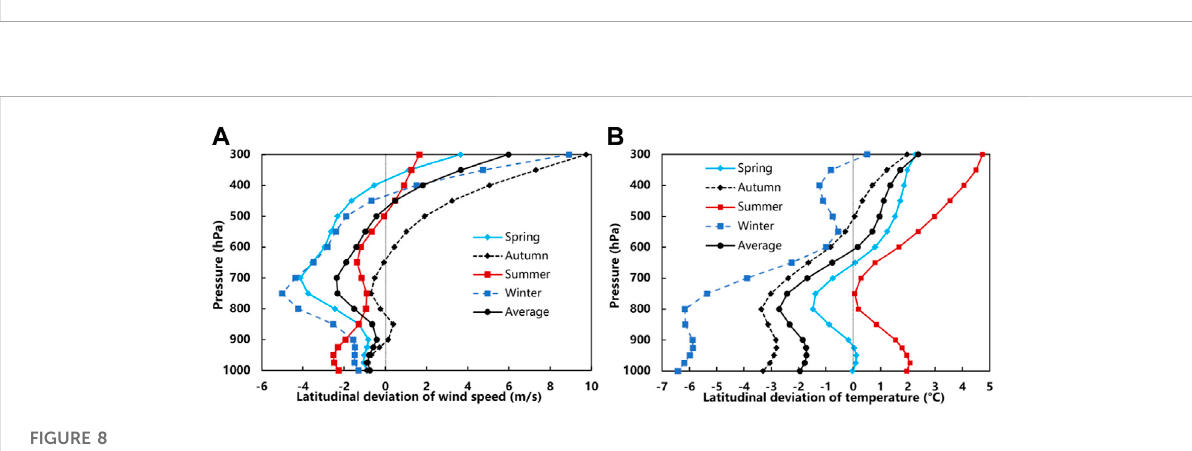
FIGURE 7 Verticalwest – eastcross – sectionsofhorizontal(shading) andvertical(contour)windspeedaveragedfrom28 ° Nto31 ° Nin (A) winter, (B) spring, (C) summer,and (D) autumnfortheperiod1999to2010.Thesolidanddashedlinesindicaterise( ω < 0)anddescend( ω > 0)oftheair fl ow,respectively.